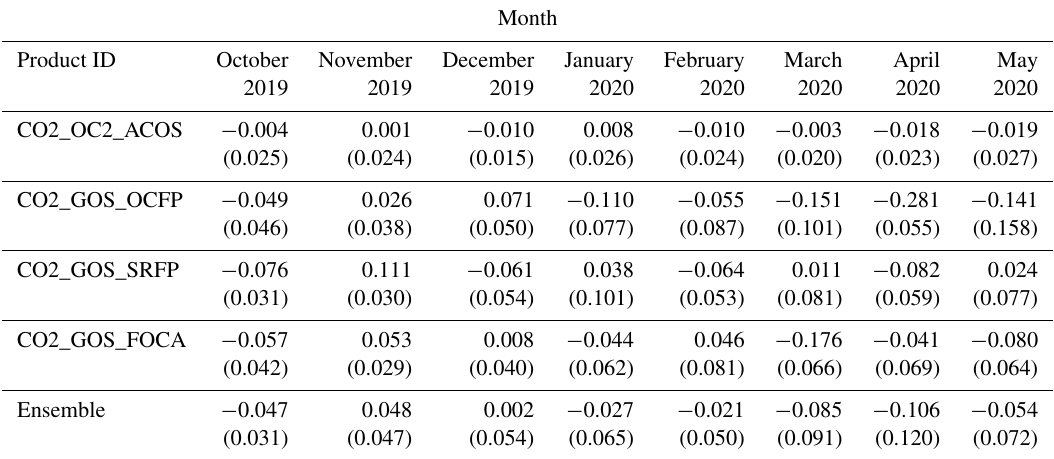
Table 4. Numerical values of the ensemble-based CO FF ( DAM ) results as shown in Fig. 13. Listed are the median values and corresponding 2 1 σ uncertainties (in brackets). The dimensionless values listed here represent the relative CO FF ( DAM )